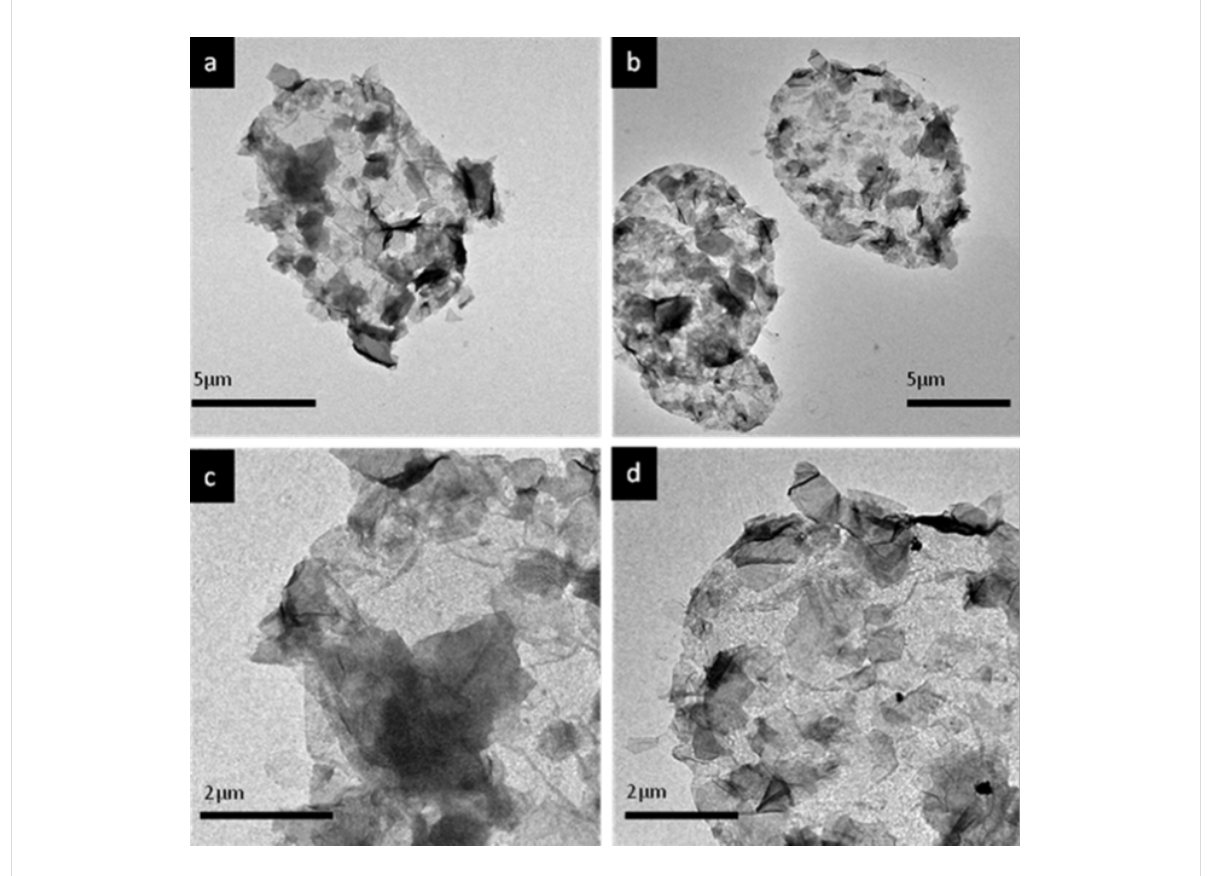
Figure 4: TEM micrographs of a) sample 2: (PSS/PAH) 20.5M + [GO/(PAH/PSS/PAH) 0.5M /GO] + (PSS/PAH) 0.5M , b) sample 3: (PSS/PAH) 20.5M + [GO/PAH] 2.5 + (PSS/PAH) 0.5M , c and d) magnification of samples 2 and 3, respectively. GO concentration was 0.2